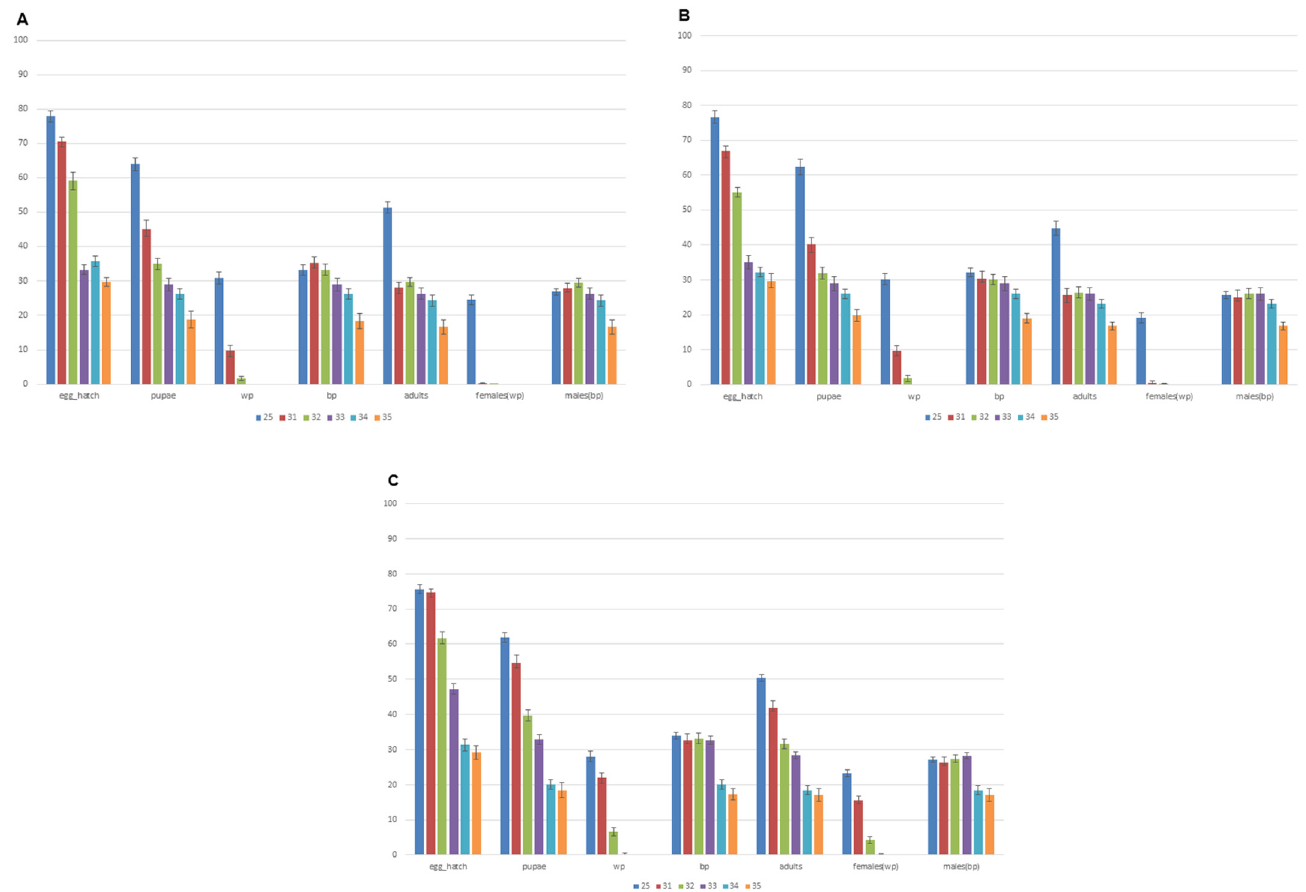
Fig 2. Percentages of egg hatch, pupation (total, white and brown pupae) and adult emergence (total, females and males) in different temperatures (25, 31, 32, 33, 34 and 35°C) according to the tsl screening described in Table 2. Results derived from a total of 5400 eggs QC screening (standard errors are indicated). (A) V8-118, (B) V8-228 and (C)